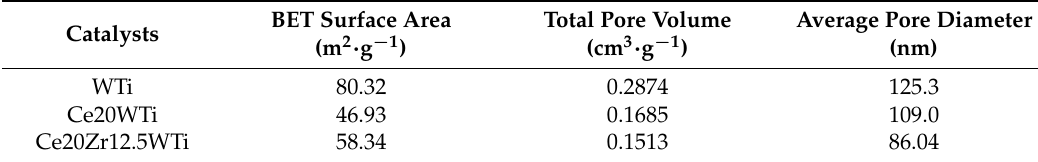
Table 1. The texture properties of the Ce x Zr y WTi catalysts.